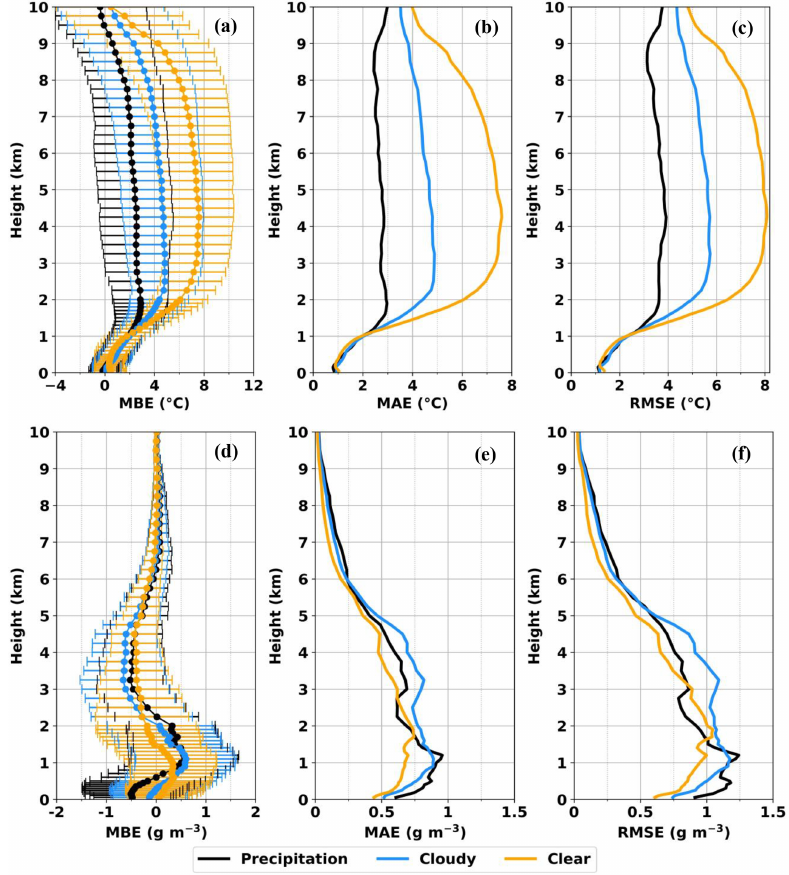
Figure 10. Vertical profiles of MBE with 1 standard deviation error bars, MAE, and RMSE for (a–c) temperature and (d–f) water vapor density during three weather conditions from the NYSM Profiler Network site at